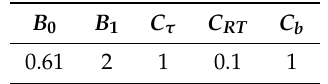
Table 2. Kelvin–Helmholtz Rayleigh–Taylor (KHRT) breakup model